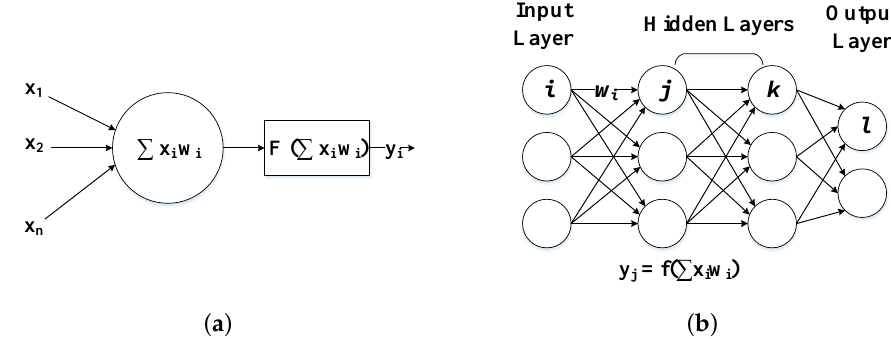
Figure 1. ( a ) Computations of an artificial neuron and ( b ) DNN composed of three FC layers.